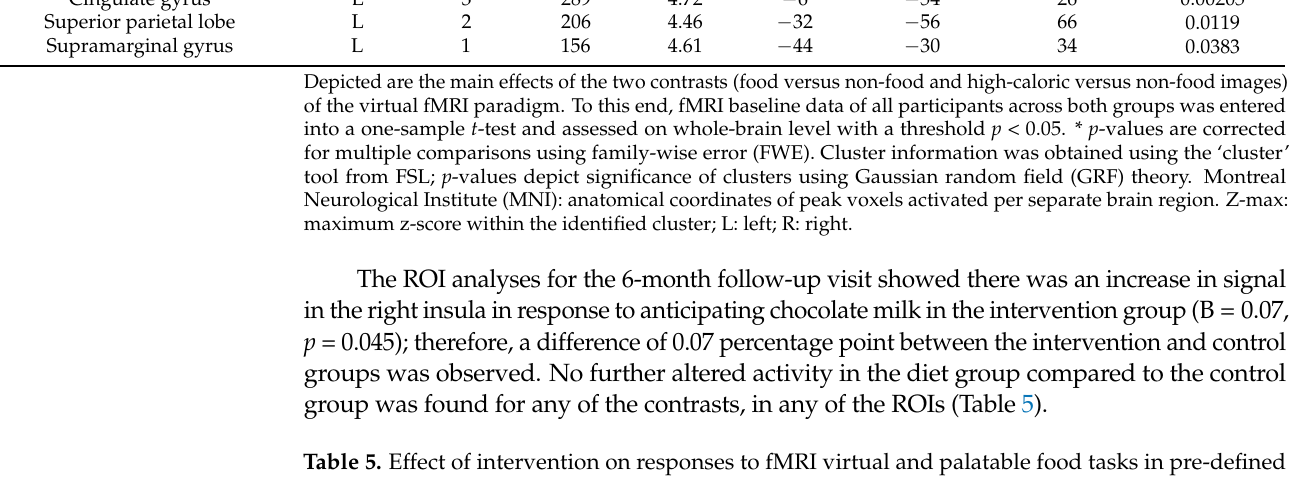
Table 5. Effect of intervention on responses to fMRI virtual and palatable food tasks in pre-defined regions of